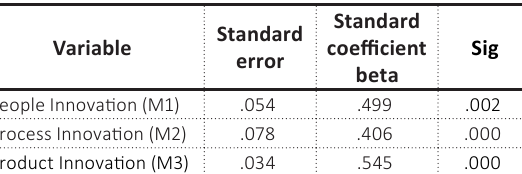
Table 9. Path analysis for the 1 st regression